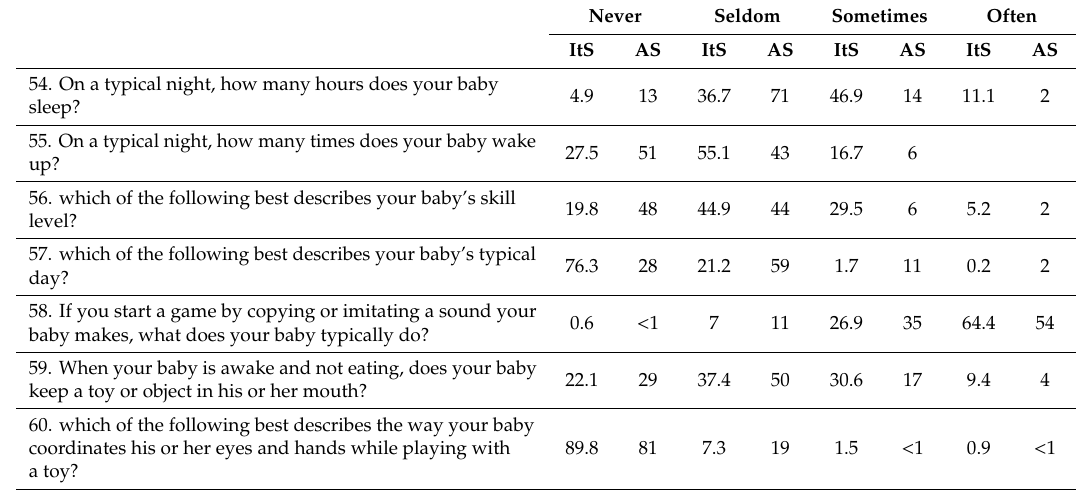
Table 3. Cont . Never Seldom Sometimes Often